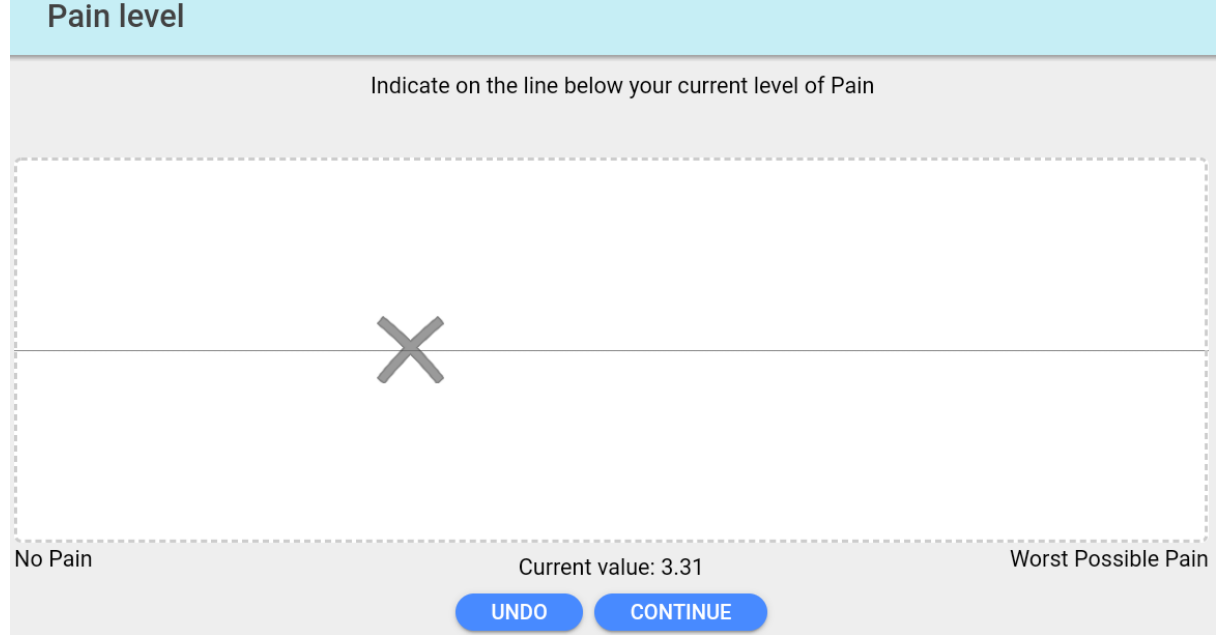
Figure 3. The electronic visual analog scale accessible via the Interactive Clinics app developed by BitGenoma Ltd,